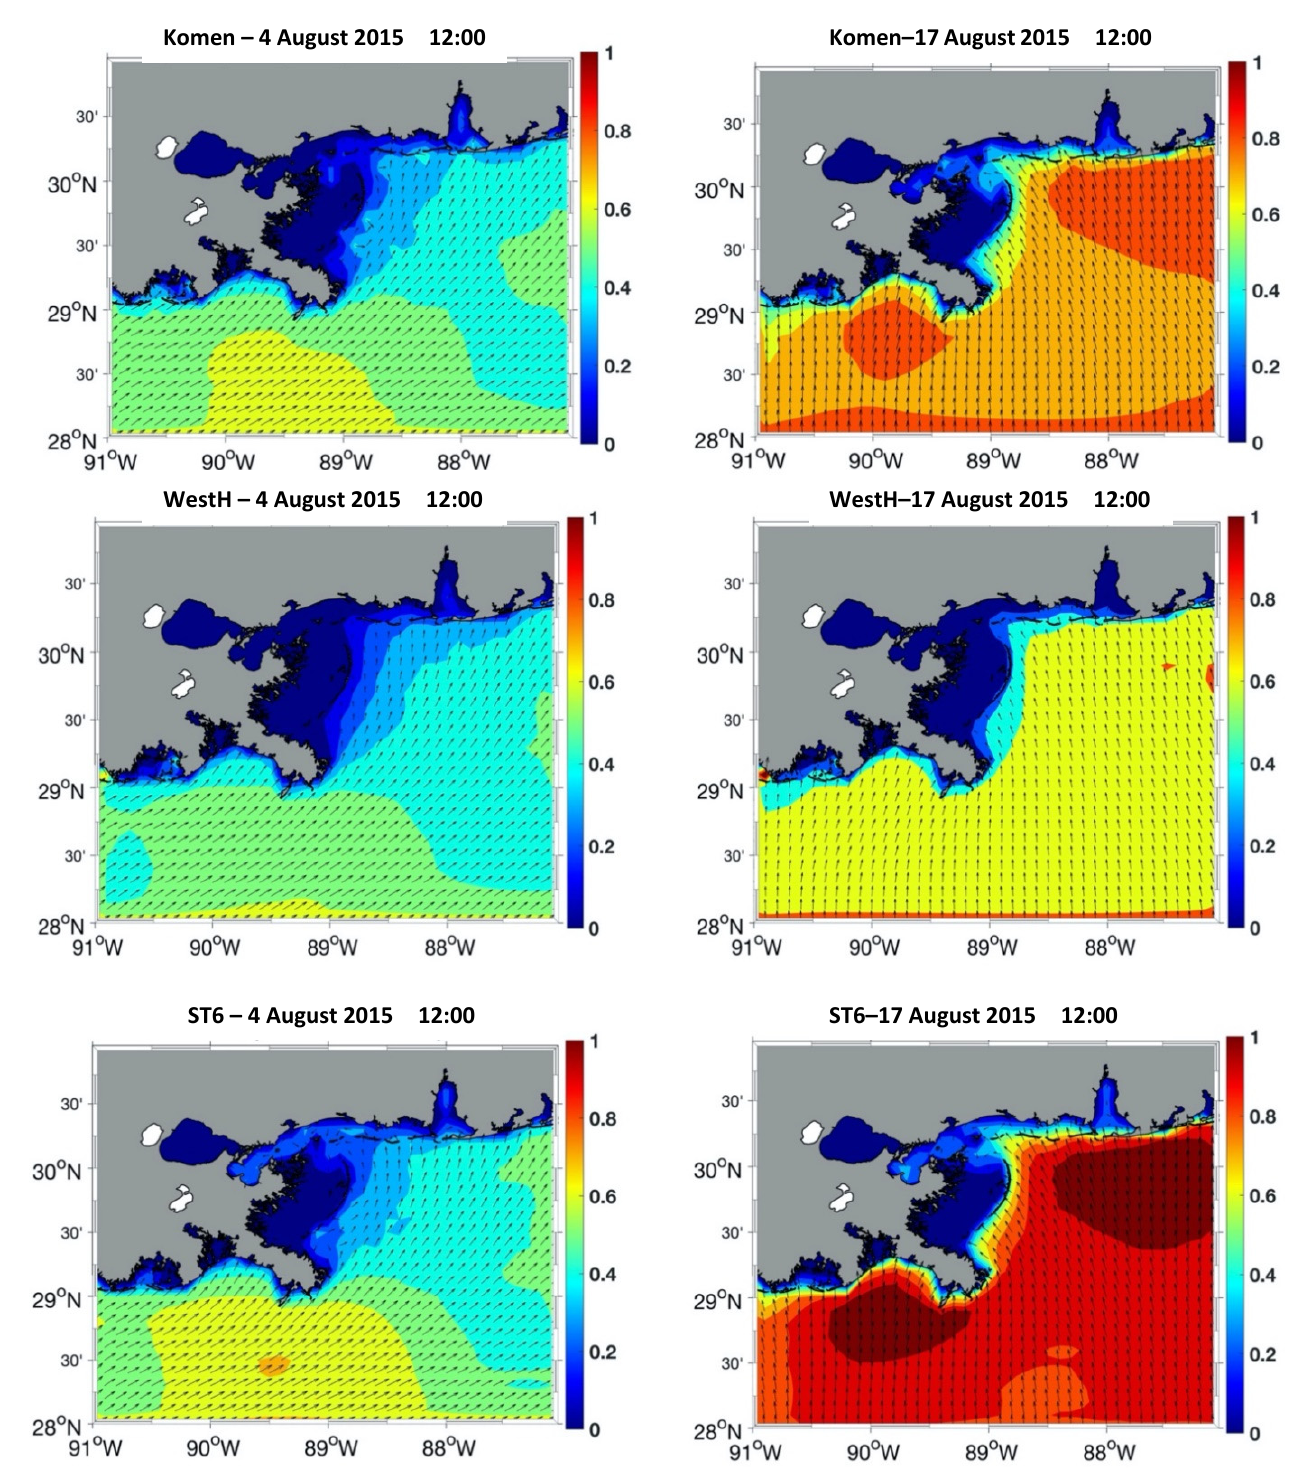
Figure 8. Significant wave height (Hs) (m) and direction at t 1 (8/4/2015; 12:00, left panels) and t 2 (8/17/2015 12:00, right panels) corresponding to simulations using Komen, Westhuysen, and ST6 whitecapping formulations.